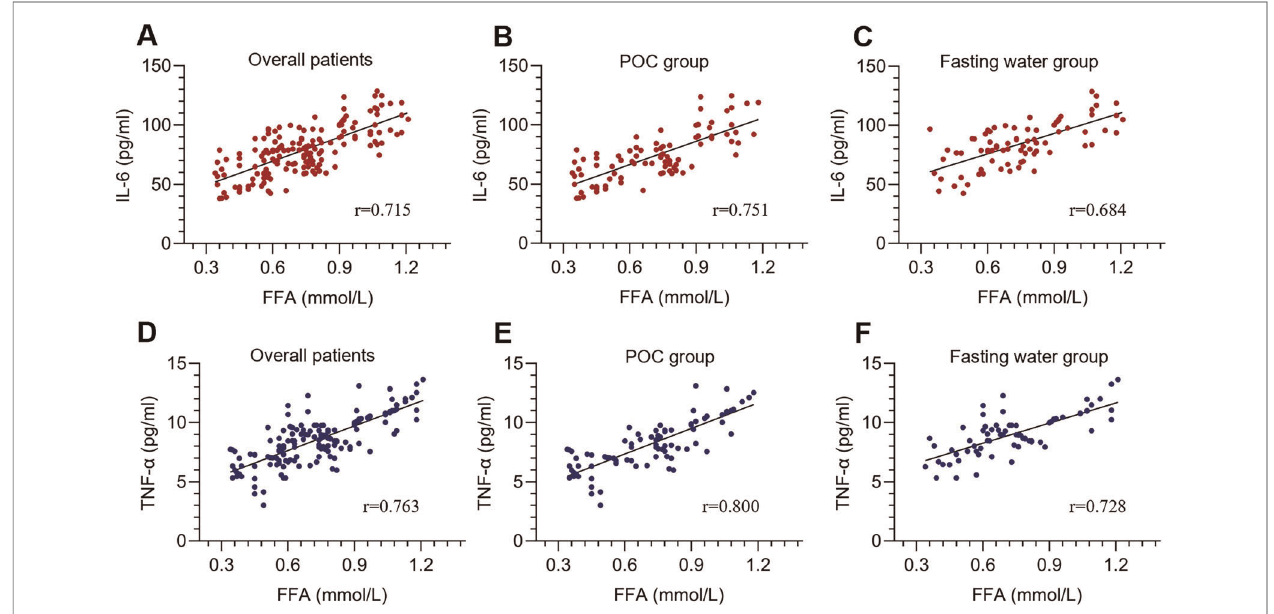
FIGURE 3 | Correlation analysis between FFA and IL-6 or TNF- α . The r refers to the Pearson correlation coef fi cient.